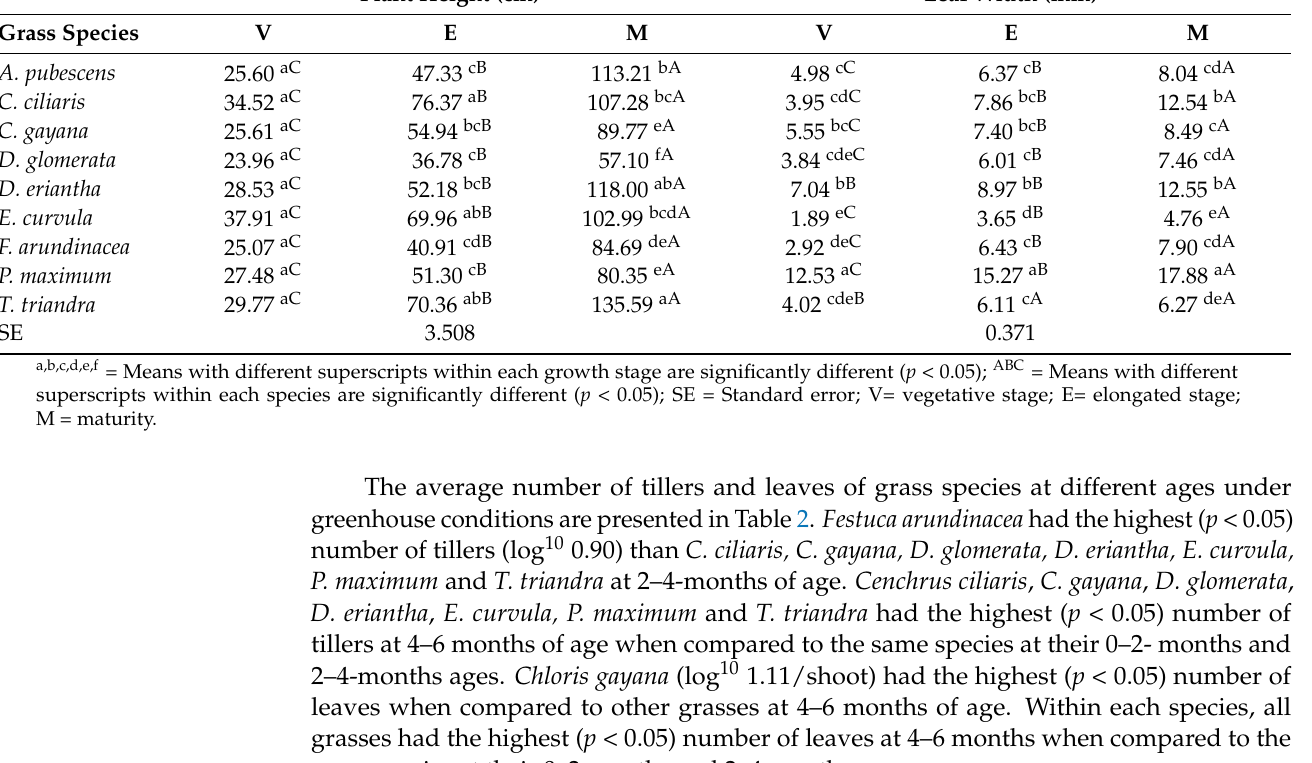
(Table 1) had the highest ( p < 0.05) LW value (12.53 mm) across all growth stages when